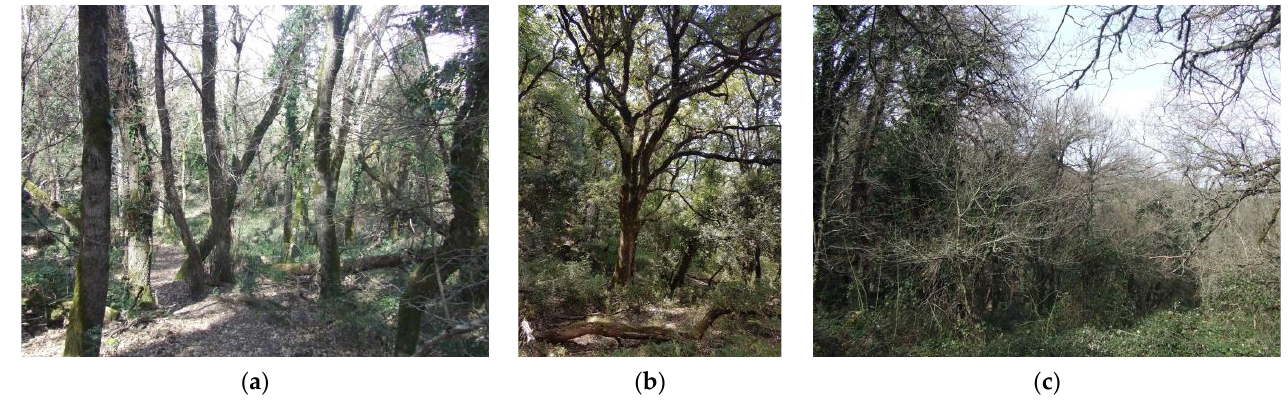
Figure 2. Structure of the old-growth forest stand: ( a ) leaning and lying trees; ( b ) dominant and suppressed trees and deadwood; ( c ) canopy gap. suppressed trees and deadwood; ( c ) canopy